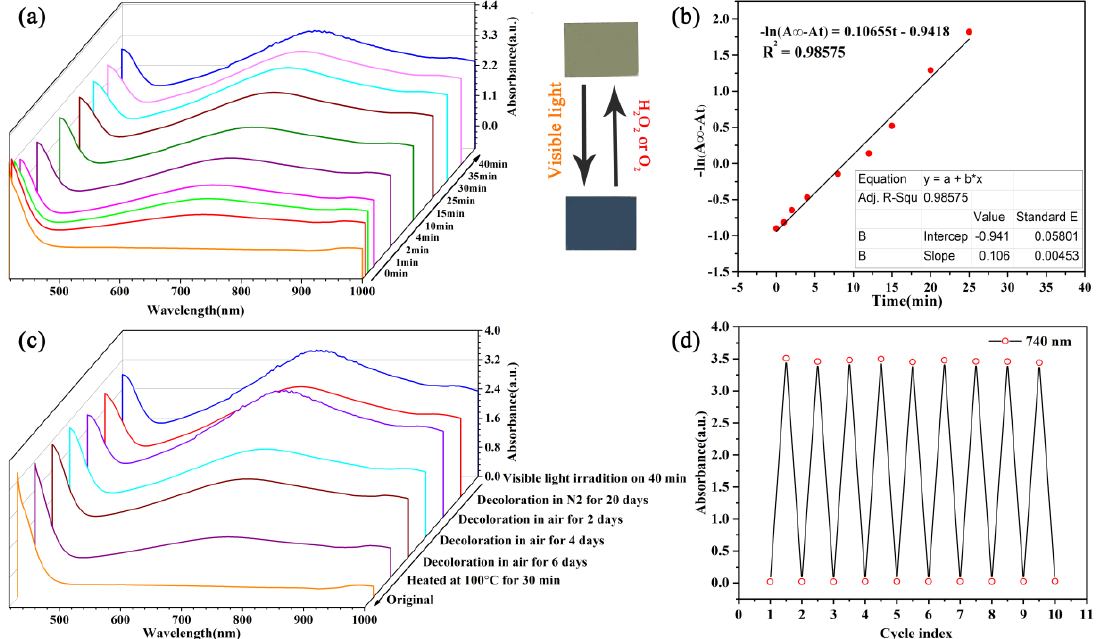
Figure 5. ( a ) UV-Vis spectrogram of the coloration process of the PMoA/PANI hybridizing thin film for different coloration time. ( b ) Kinetic plot of the first-order photochromic process in the PMoA/PANI hybridizing thin film. ( c ) UV-Vis spectrogram of the decoloration process of the PMoA/PANI hybridizing thin film for different decoloration approach. ( d ) The reversibility of the coloration cycle of the PMoA/PANI hybridizing thin film in H 2 O 2 .